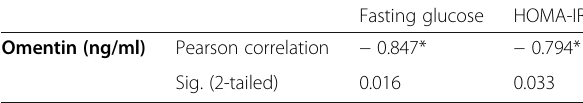
Table 4 Correlations between omentin with fasting glucose and HOMA-IR in HCHF + swim group